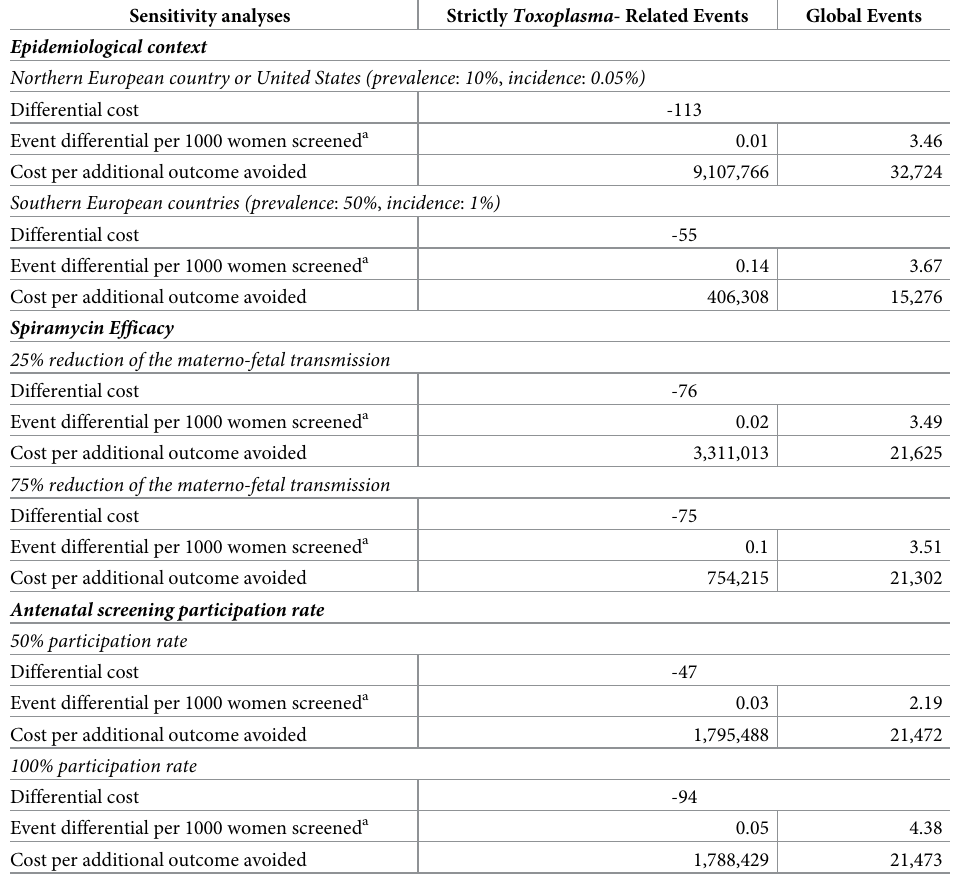
Table 5. Sensitivity analyses: Long term assessment (Toxoscreen project). Sensitivity